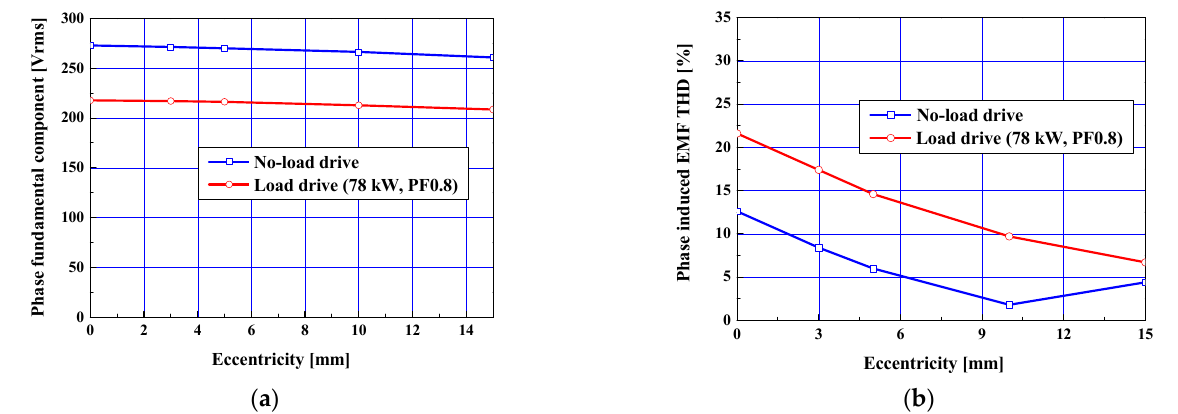
Figure 9. Induced EMF at no-load and load drives according to the eccentricity with the slit: ( a ) fundamental component, and ( b ) THD.